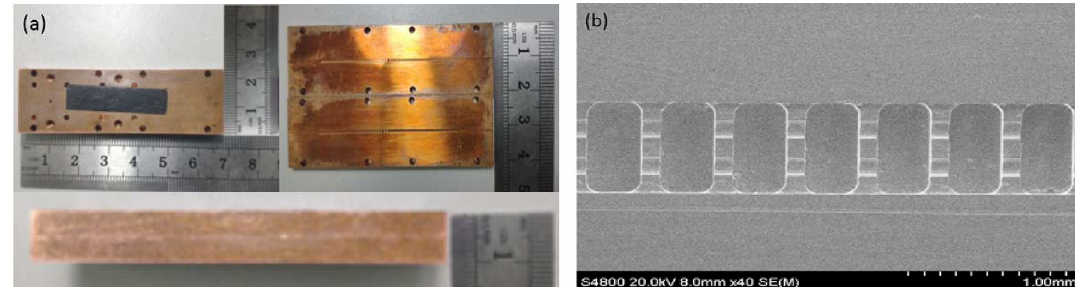
Figure 25. Photos of the fabricating structure. ( a ) Size of the structure. ( b ) SEM images of vanes.